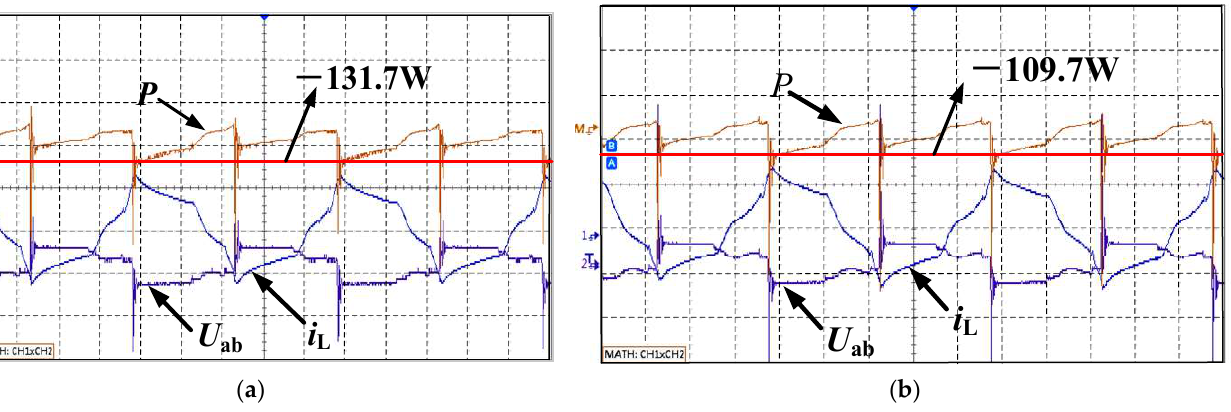
Figure 19. Instantaneous power waveforms: ( a ) instantaneous power waveform of converter before backflow power optimization; ( b ) instantaneous power waveform of converter after backflow power optimization.